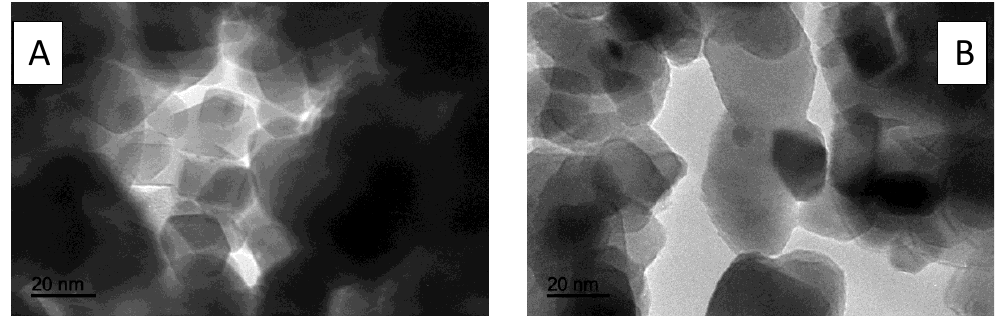
Figure 6. TEM micrographs of Ni-0.5-DP solid after the second reutilization using UV ( A ) or solar ( B ) irradiation.